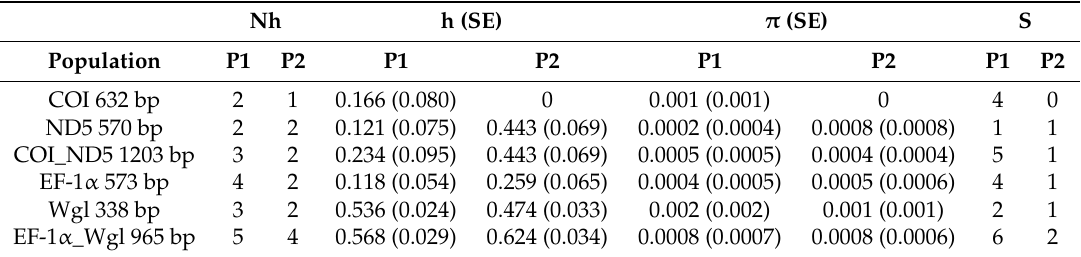
Table 5. Molecular diversity indices for mtDNA (COI and ND5) and nuclear (EF-1 α and Wgl) genes in two populations (P1 and P2) of Scolitantides orion from